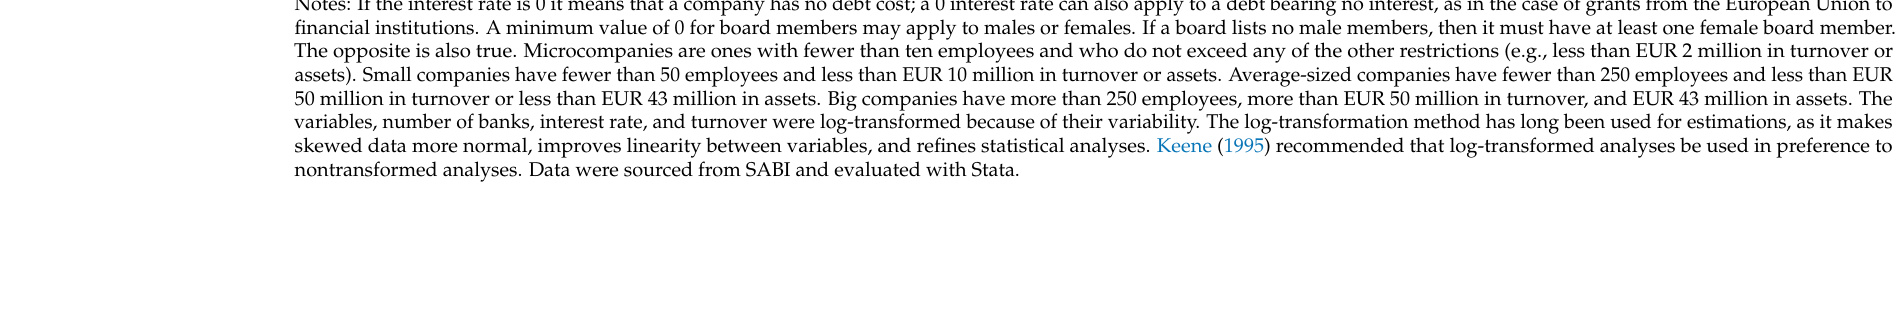
Panel 4. Segment and supporting